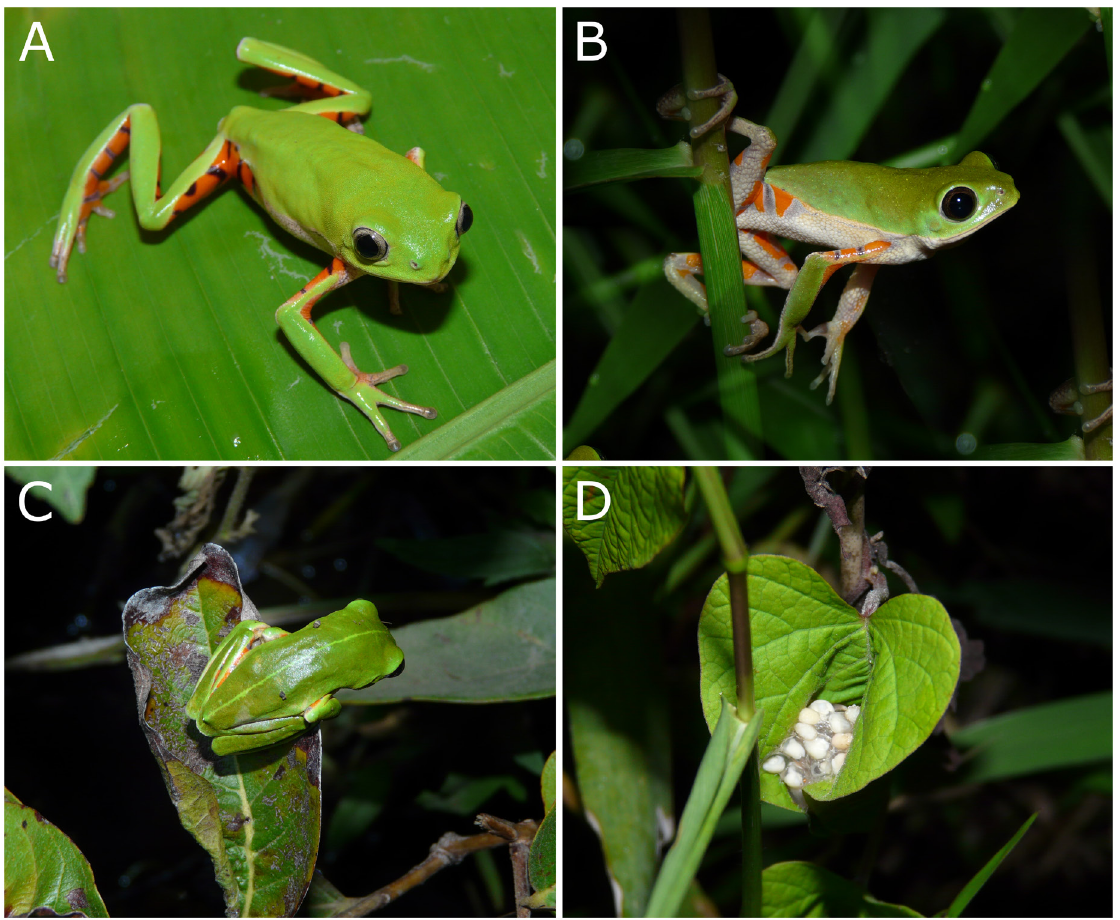
Fig. 3. Pithecopus gonzagai sp. nov. from Brazilian north-eastern, in life. A . From the municipality of Pilar, state of Alagoas (AL). B . From the municipality of Recife, state of Pernambuco (PE). C . From the municipality of São Miguel dos Milagres, AL. D . Arboreal eggs from the municipality of Poção, PE. Photographs by M.